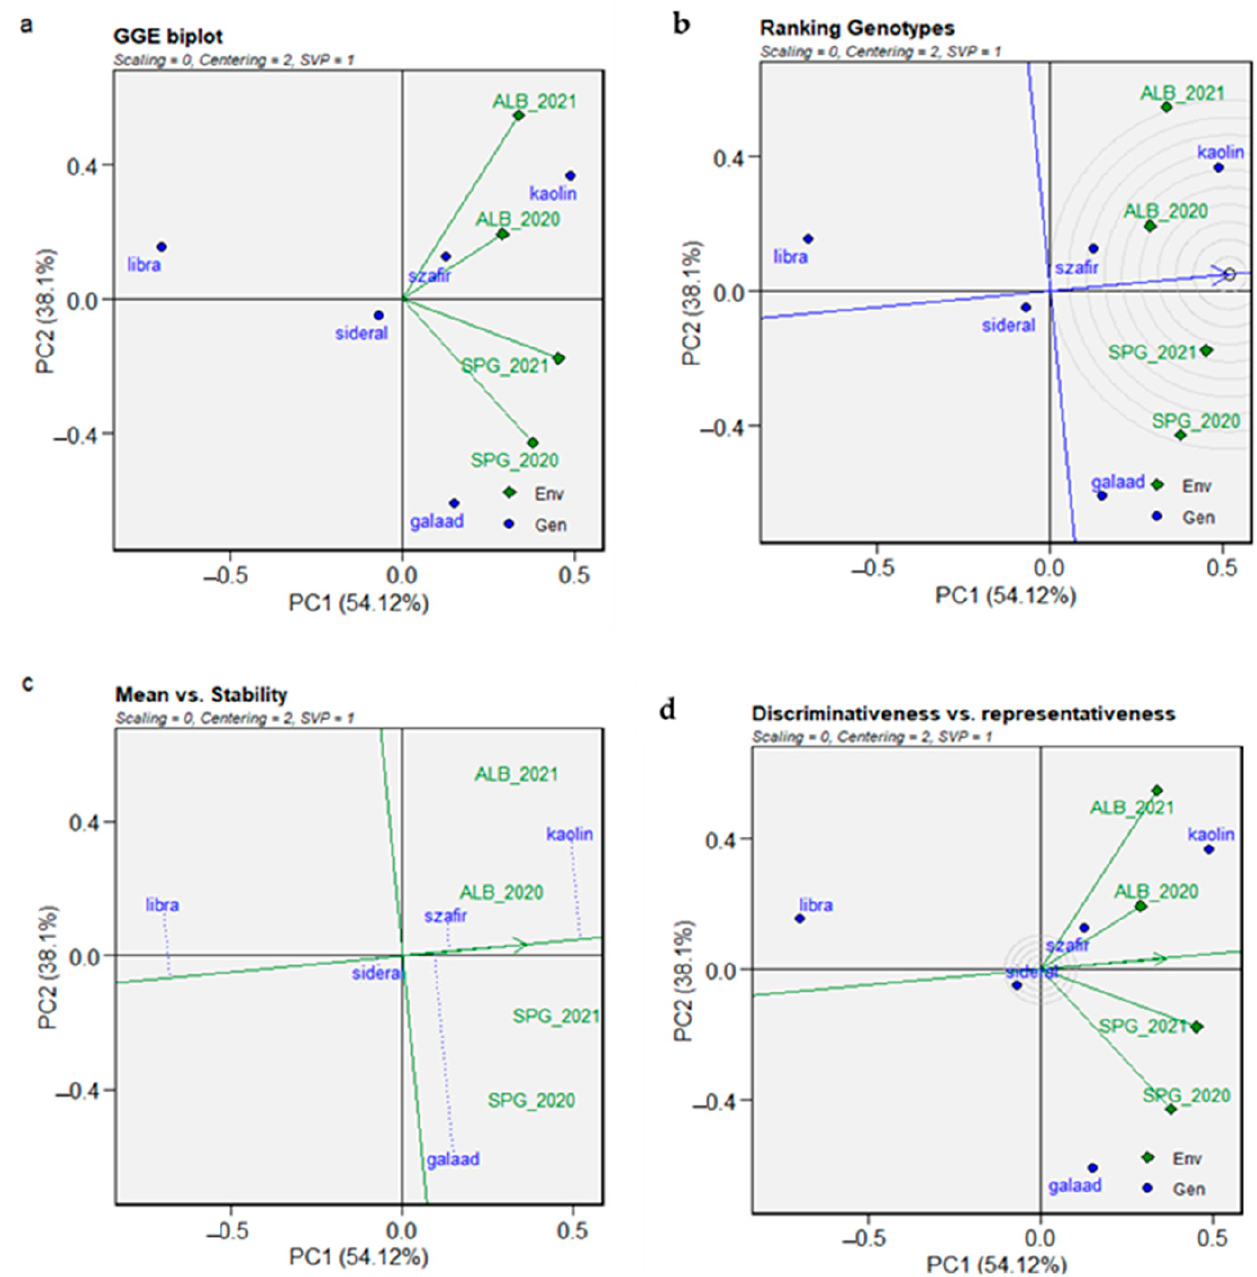
Figure 6. Comprehensive examination of genotypes and environments. GGE Biplot visualization ( a ); ranking genotypes ( b ) within environments and representativeness of test environments; ( c ) comparison of genotype with the ‘ideal’ genotype for both mean and yield stability; ( d ) comparison of environments based on both discriminating ability and representativeness of the target environ- ment.